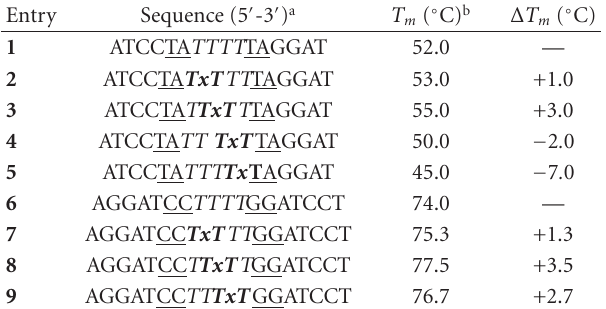
Table 4: Thermal melting temperatures ( ◦ C) of CNAgp within hairpin